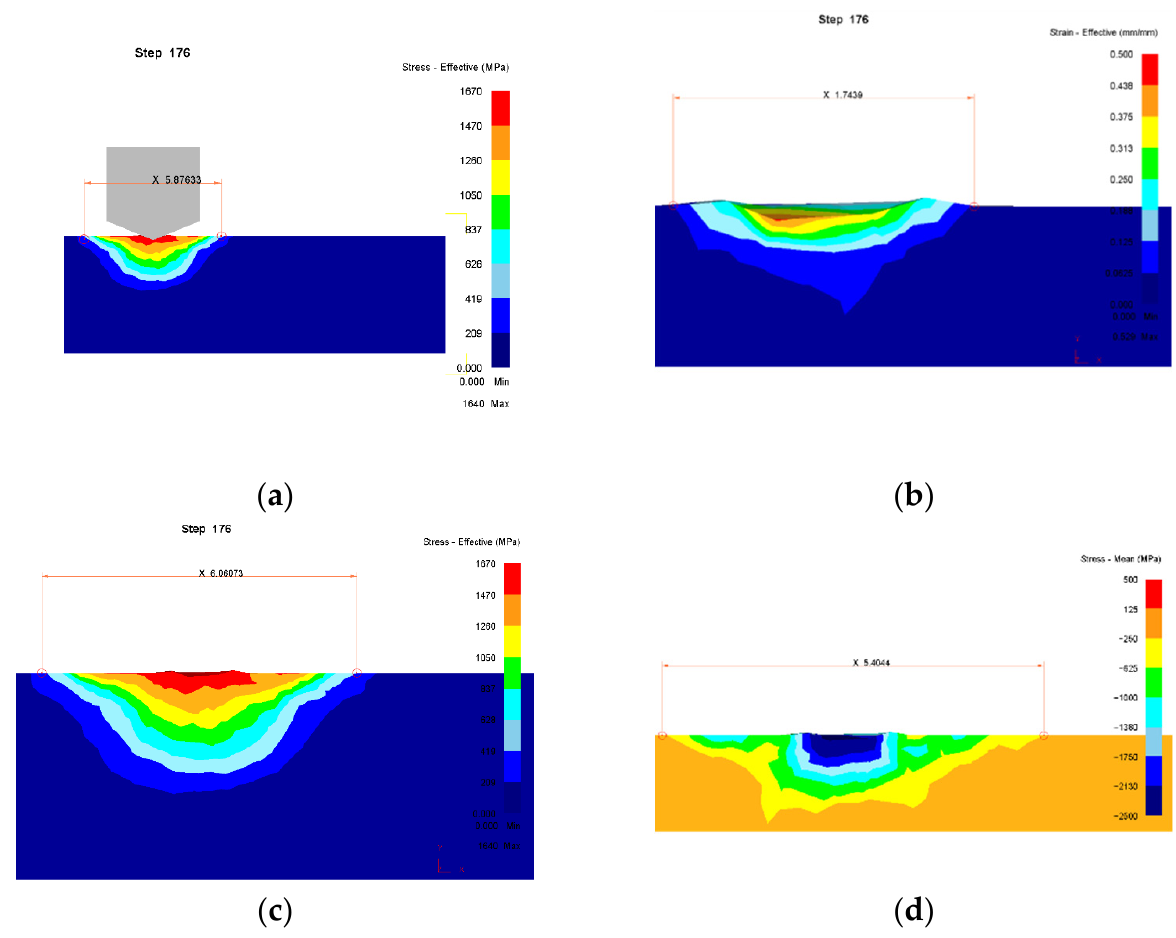
Figure 8. Diagrams of the stress-strain state under the indenter: ( a ) stress intensity, general view; ( b ) the accumulated strain; ( c ) stress intensity, detailed; ( d ) mean stress (hydrostatic pressure) values are negative, according to the theory of metal forming for compressive stress).